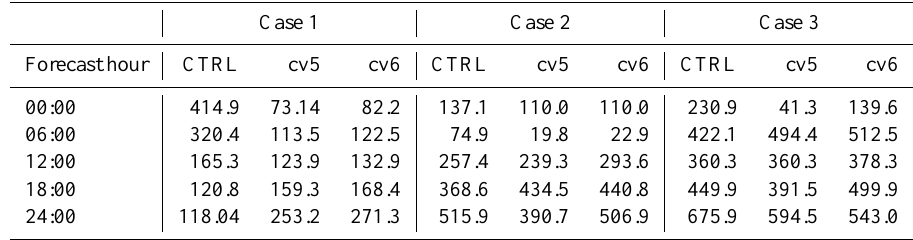
Table 1. Track error in kilometres for the three depression cases with respect to IMD data. Case 1 Case 2 Case 3 Forecast hour CTRL